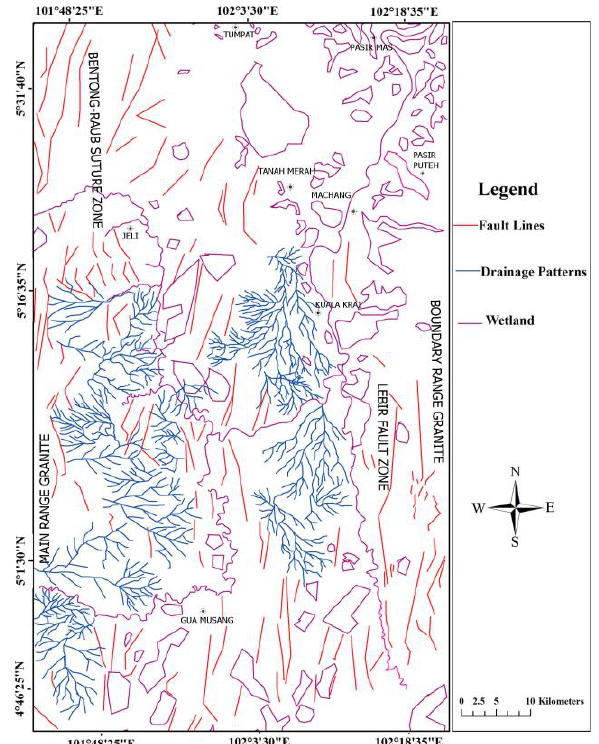
Figure 4. Structural lineament map of the Kelantan state derived from directional filtering to HV polarization